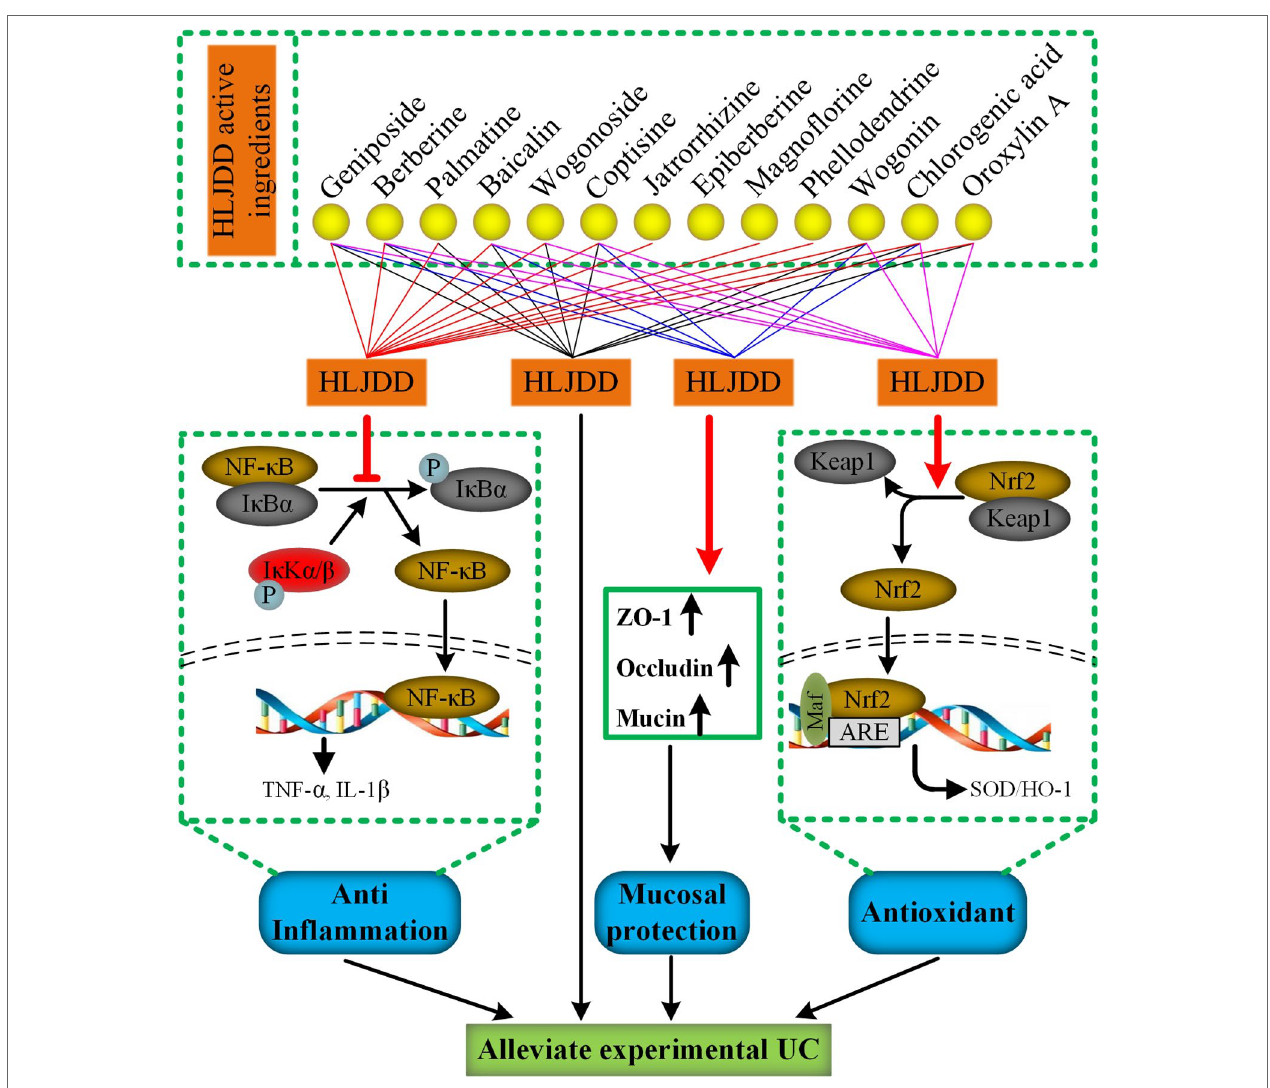
FIgURE 11 | The mechanism of HLJDD alleviate DSS-induced UC. (For interpretation of the references to color in this figure legend, the reader is referred to the web version of this article)